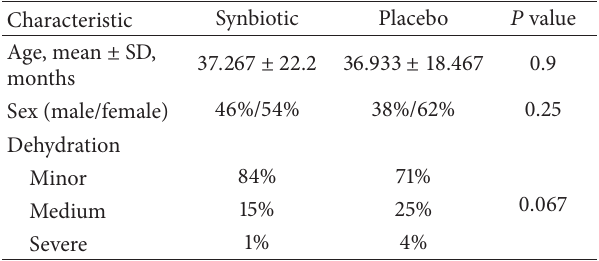
Table 1: General characteristics of patients in both synbiotic and placebo groups.